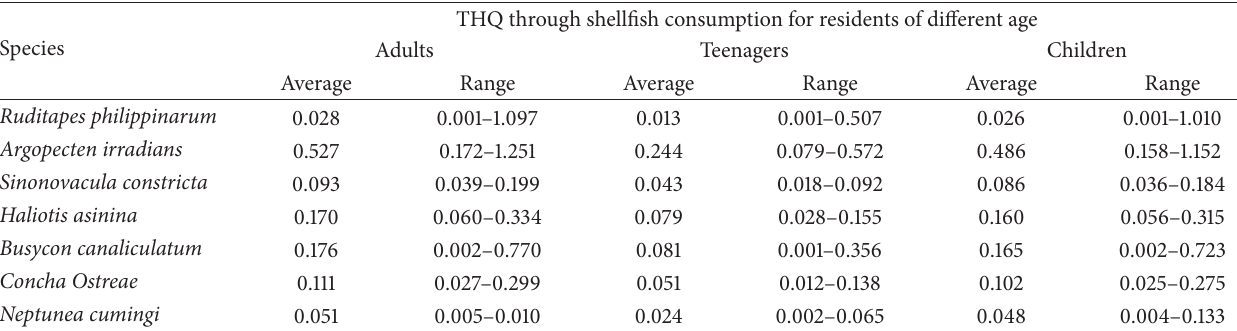
Table 5: THQ of Hg in the different species of shellfish from northern Jiaozhou Bay. THQ through shellfish consumption for residents of different Species